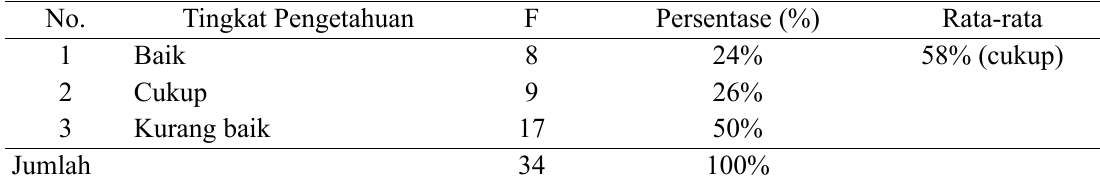
Tabel 2. Distribusi frekuensi pengetahuan (paham) lansia tentang nutrisi di Posyandu lansia No.